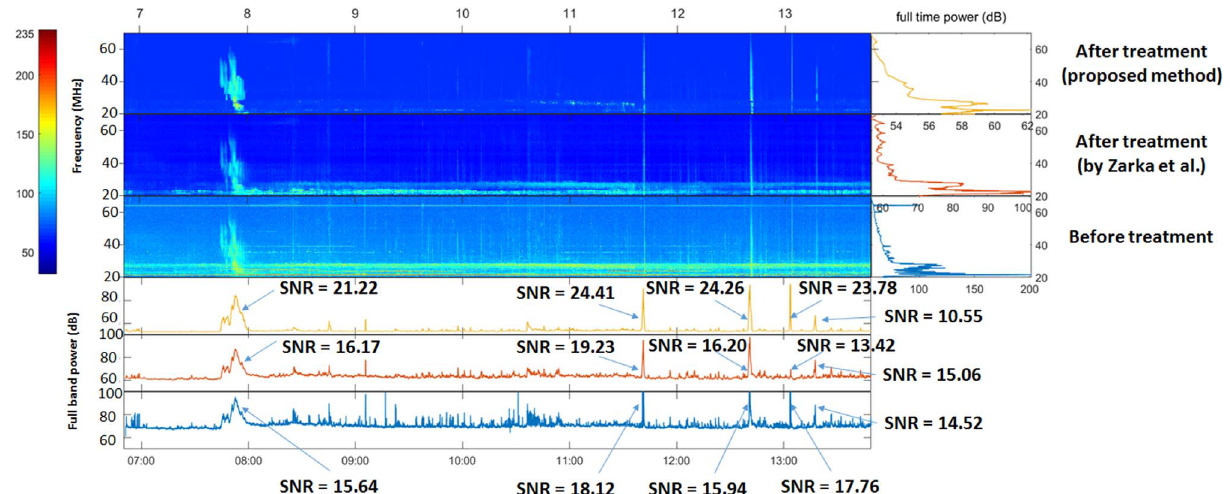
Fig. 9. Example of the dynamical spectrum of a signal by applying Zarka et al. (2004) method and the proposed background noise removal process.